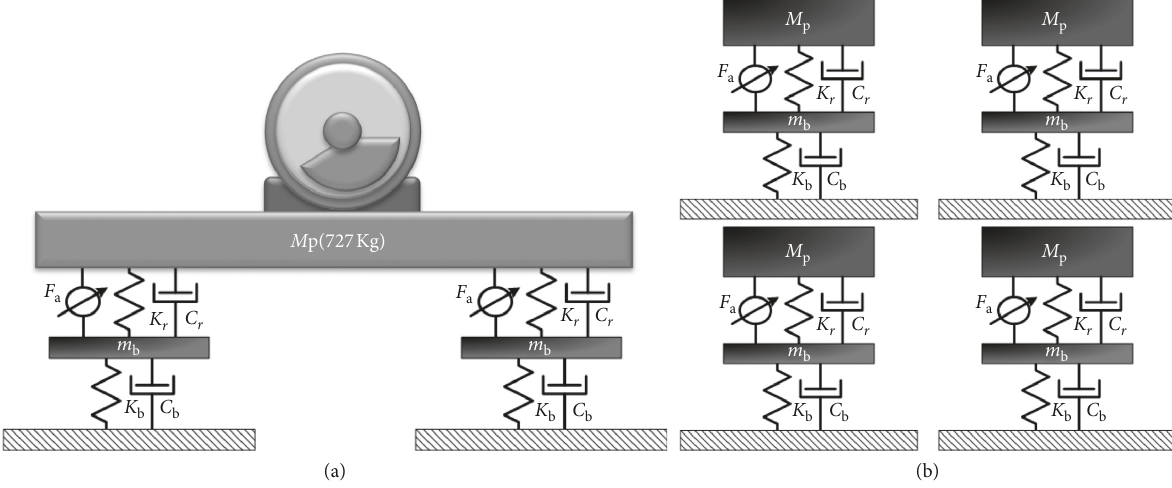
Figure 19: Design schematics of a controller for the 7-DOF system with a hybrid mount. (a) Original system. (b) Control